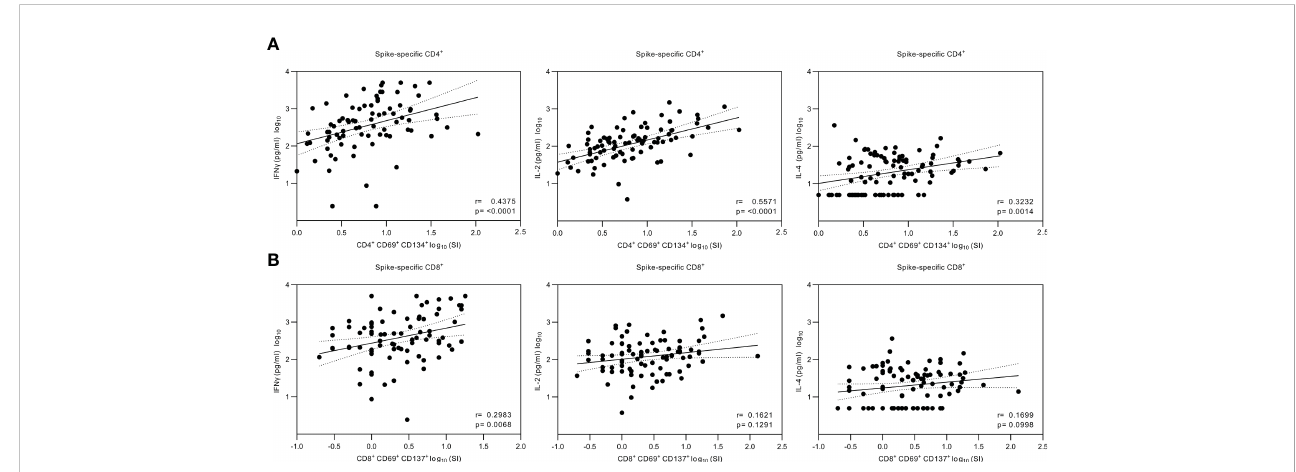
FIGURE 6 Correlation of the secreted cytokines and SARS-CoV-2 spike-speci fi c T cell responses. (A) , Nonparametric Spearman correlation analysis of SARS-CoV-2 (wt) spike-speci fi c CD4 + T cells and secreted IFN- g , IL-2 or IL-4 cytokines measured from the supernatants of SARS-CoV-2 (wt) spike-stimulated PBMCs. The stimulated PBMCs were collected from 32 HCWs at three weeks, three, and six to eight months after the second vaccine dose and three weeks and three months after the third vaccine dose and grouped together for analysis (n=81 for IFN- g , n=87 for IL-2, and n=88 for IL-4). (B) , Nonparametric Spearman correlation analysis of SARS-CoV-2 (wt) spike-speci fi c CD8 + T cells and secreted cytokines (n=81 for IFN- g , n=88 for IL-2, and n=88 for IL-4). Dotted lines indicate 95% con fi dence intervals